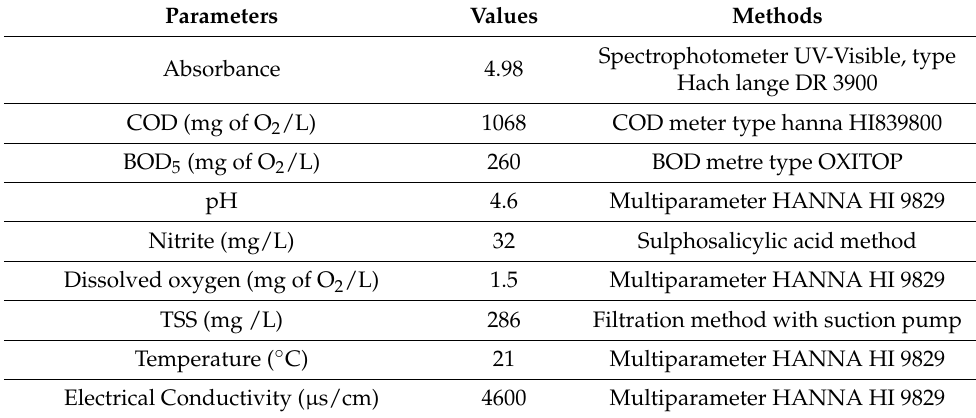
Figure 12. Experimental device of the adsorption system on a fixed bed column [15]. Figure 4. Experimental device of the adsorption system on a fixed bed column [19]. Table 2. Measured parameters of station 5 and equipment used. Table 6. Measured parameters of station 5 and equipment